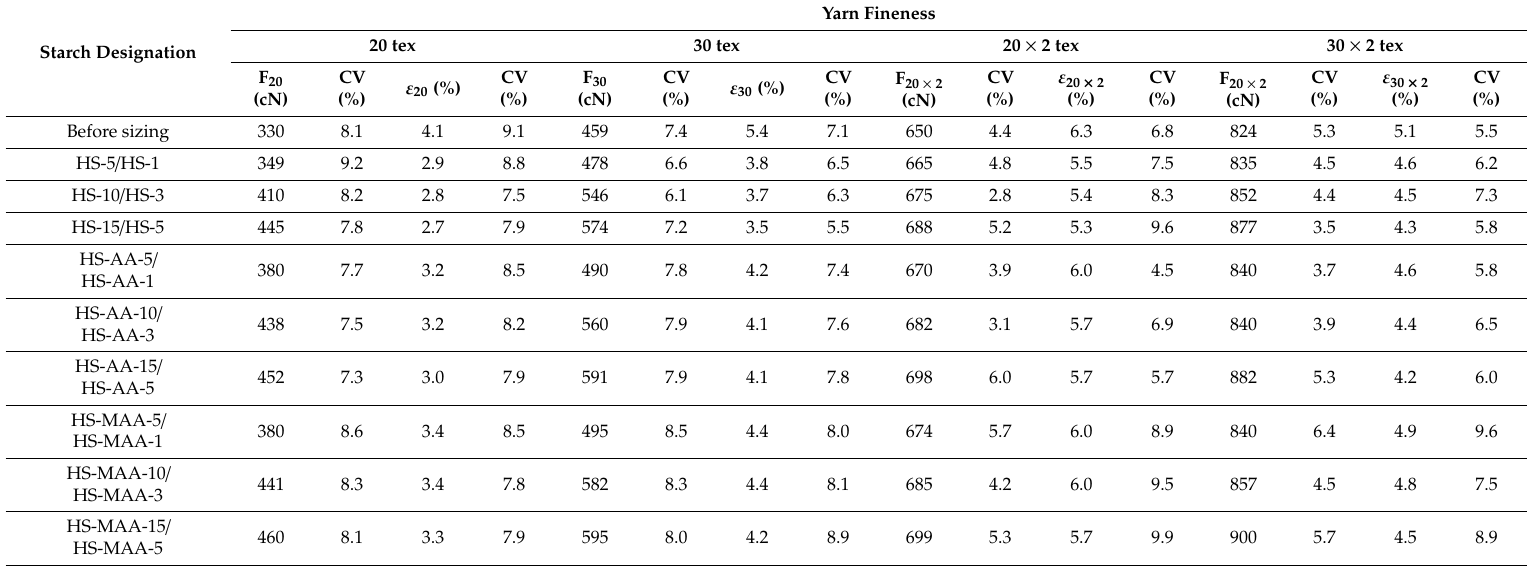
Table 7. Breaking forces and elongations at break of the yarn per counts and starch